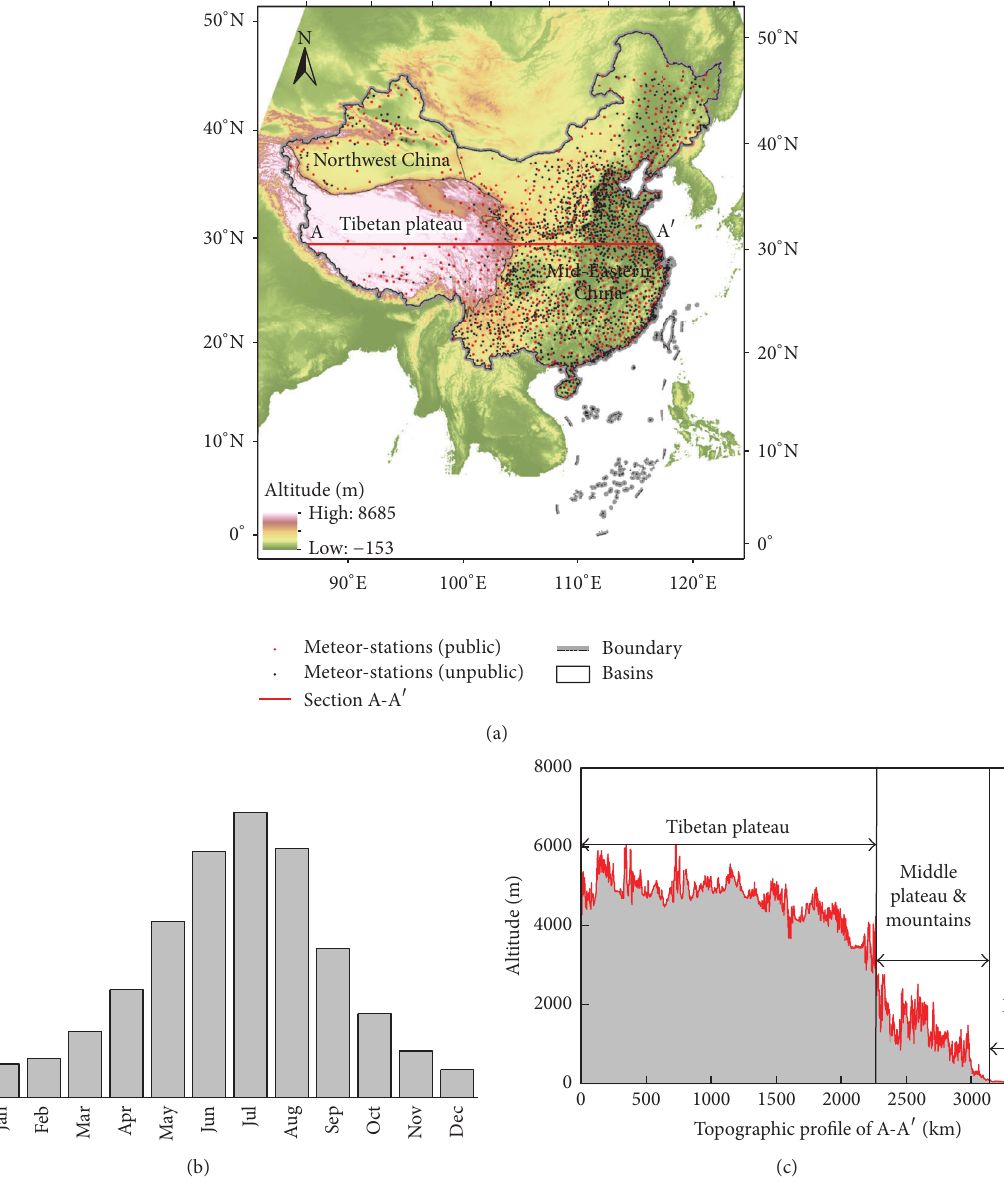
Figure 1: Topographical map of China and geographic distribution of the precipitation gauges (a), distribution of average monthly precipi- tation (b), and a typical topographic profile across China